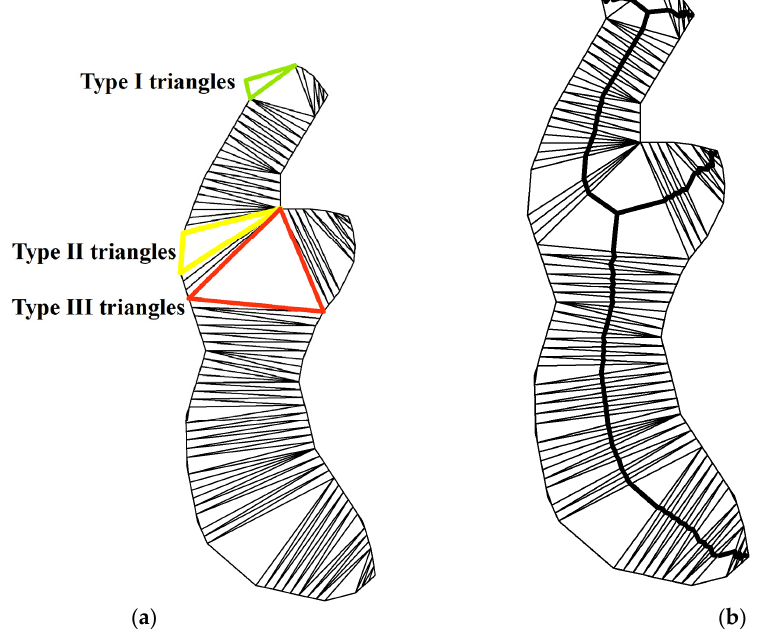
Figure 2. ( a ) Classification of triangles in the Delaunay triangle network; ( b ) skeletal lines of faceted elements.